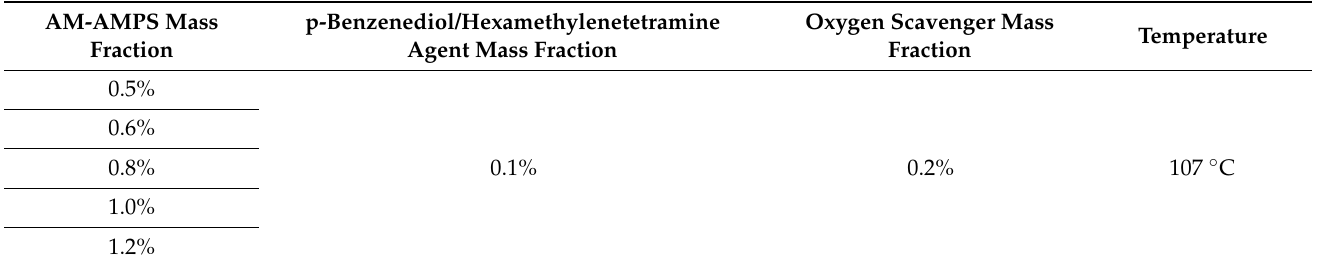
Table 3. Scheme of the polymer mass fraction optimization experiment.